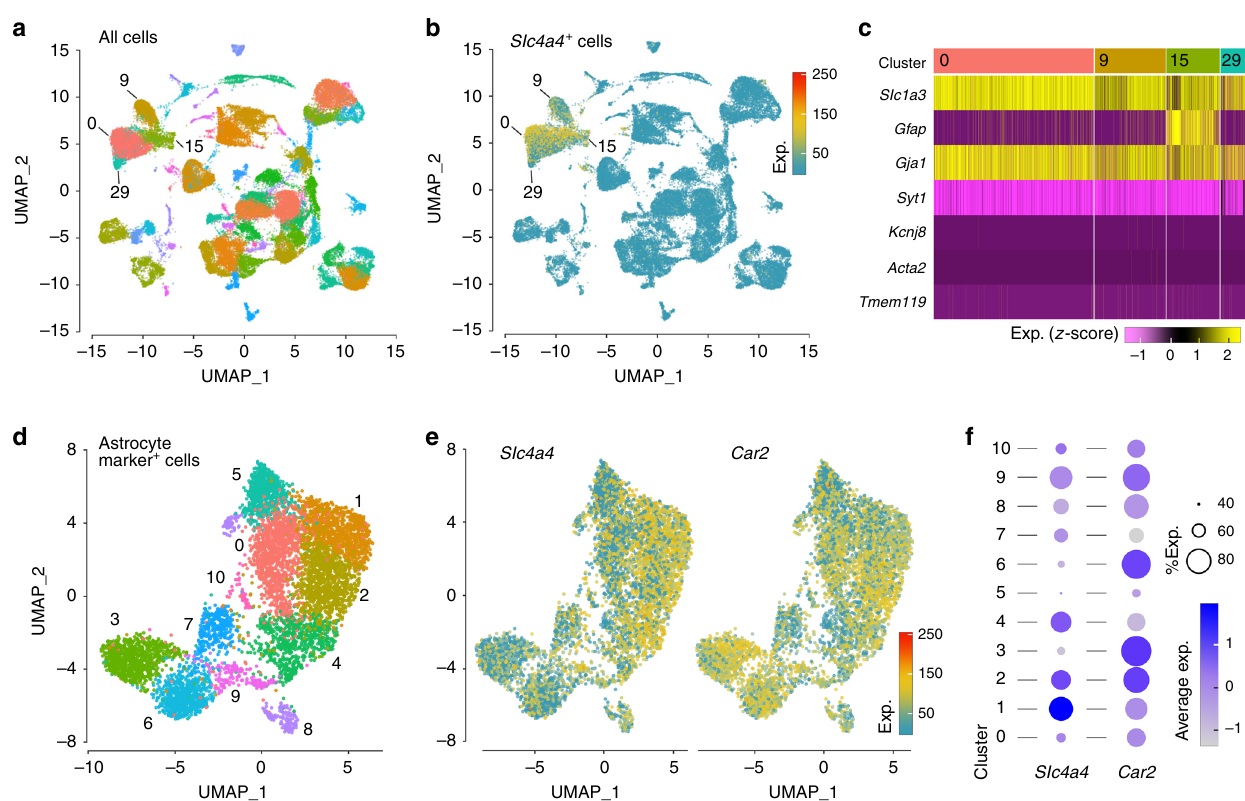
Fig. 4 NBCe1 gene Slc4a4 is expressed predominantly in astrocytes. a Visualisation of cerebral cortex single-cell mRNA sequencing data from the Mouse Brain Atlas database 54 using Uniform Manifold Approximation and Projection (UMAP). Each colour represents a ‘ cluster ’ of cells that share similarities in RNA expression pro fi le. Expression data from a total of 49,703 cells were analysed yielding 63 distinct clusters. b Distribution of Slc4a4 expression across all the identi fi ed clusters of cortical cells. Cells within the four labelled clusters display the highest differential expression of Slc4a4 , illustrated as reads per million of RNA molecules detected. c Slc4a4 -positive cell clusters show high level of expression of astrocyte-speci fi c marker genes. Heatmap showing scaled (z-score) cell marker gene expression in selected cell clusters: 0, 9, 15, and 29. Genes indicated are astrocyte-associated: Slc1a3 , glutamate aspartate transporter 1 (GLAST-1); GFAP , glial fi brillary acidic protein, Gja1 , connexin 43. Also analysed are neuron-associated gene: Syt1 , synaptotagmin-1; pericyte-associated gene: Kcnj8 , Kir6.1; smooth-muscle cell-associated gene: Acta2 , α -smooth-muscle actin; and microglia-associated gene: Tmem119 , transmembrane protein 119. Magenta colour indicates low gene expression, yellow colour indicates high gene expression. d Visualisation and re-clustering of cells identi fi ed as astrocytes using UMAP at high resolution. Expression data from a total of 6760 cells showing high expression of astrocyte-speci fi c gene markers were analysed and yielded 11 distinct astroglial sub-clusters based on similarities in the RNA expression pro fi le. e Expression pro fi le of Slc4a4 and carbonic anhydrase 2 ( Car2 ) in cortical cell clusters identi fi ed as astrocytes. Expression levels are illustrated as reads per million of RNA molecules detected. f Relative expression of Slc4a4 and Car2 genes within the astroglial sub-clusters. Percentage of cells within each cluster that are positive for Slc4a4 and Car2 is represented by the size of the circle and the degree of the relative expression is represented by the colour gradient. Circles representing clusters with a high proportion of cells that strongly express the gene of interest appear larger and darker